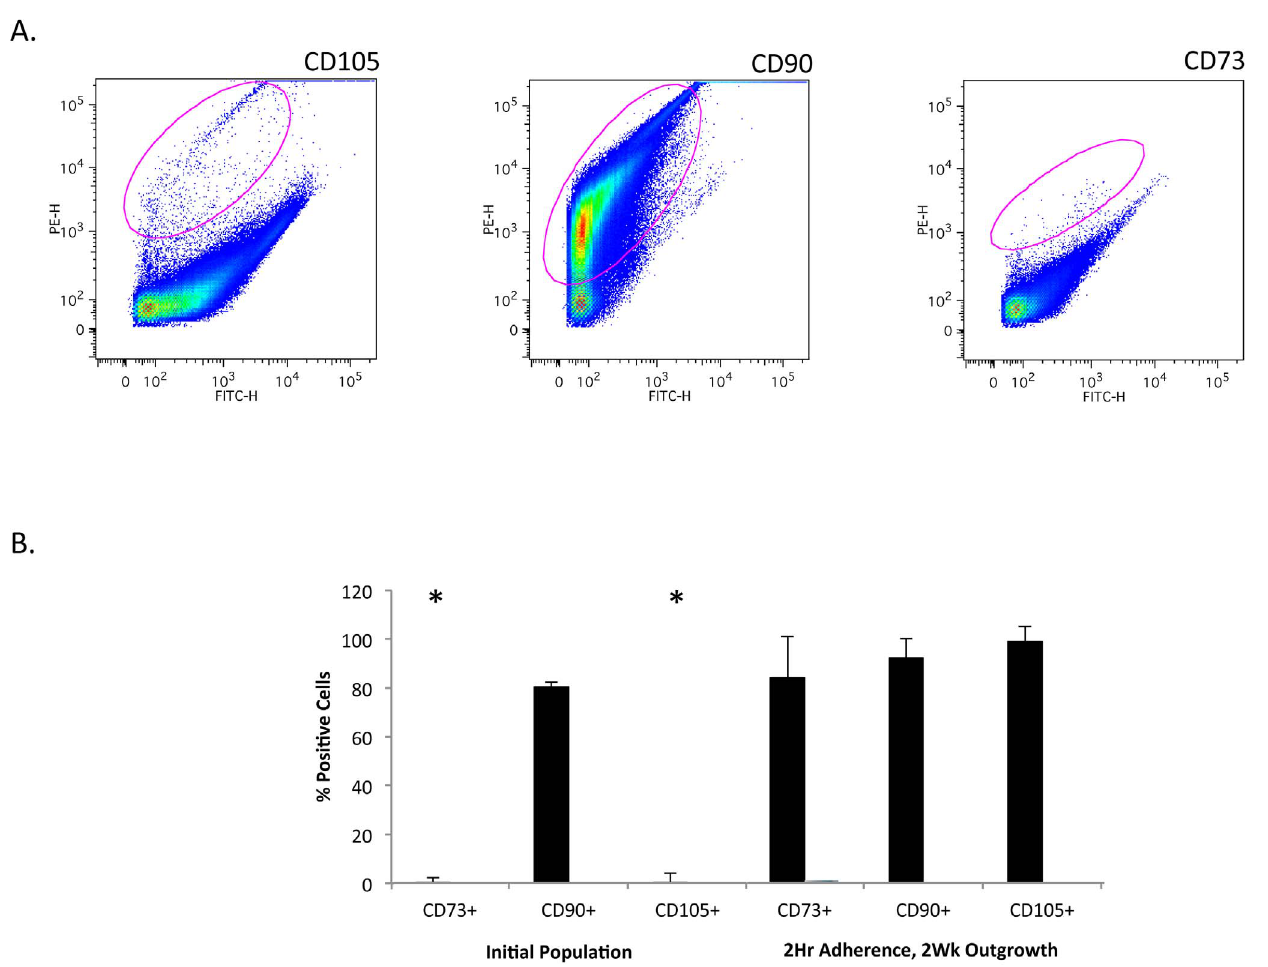
Fig. 3. Analysis of CD105, CD90 and CD73 positive cells in a single cell suspension from traumatized muscle. A. single cell suspension (Figure 1C) from collagenase digested traumatized muscle tissue was processed for flow cytometry using fluorescent-conjugated antibodies against the cell surface markers indicated in the figure. The gated regions, indicated by a red circle within the plot, contain the positive cells. B. For each marker the bar graph reflects the number of positive cells isolated (mean ¡ SEM, n 5 12) as inFigure 1B (2 Hr Adherence, 2 Wk outgrowth) or as inFigure 1C (Initial Population). Significant difference is noted (*) between CD73 and CD105 in the initial population and the other conditions (Student’s t-test, p # 0.01).